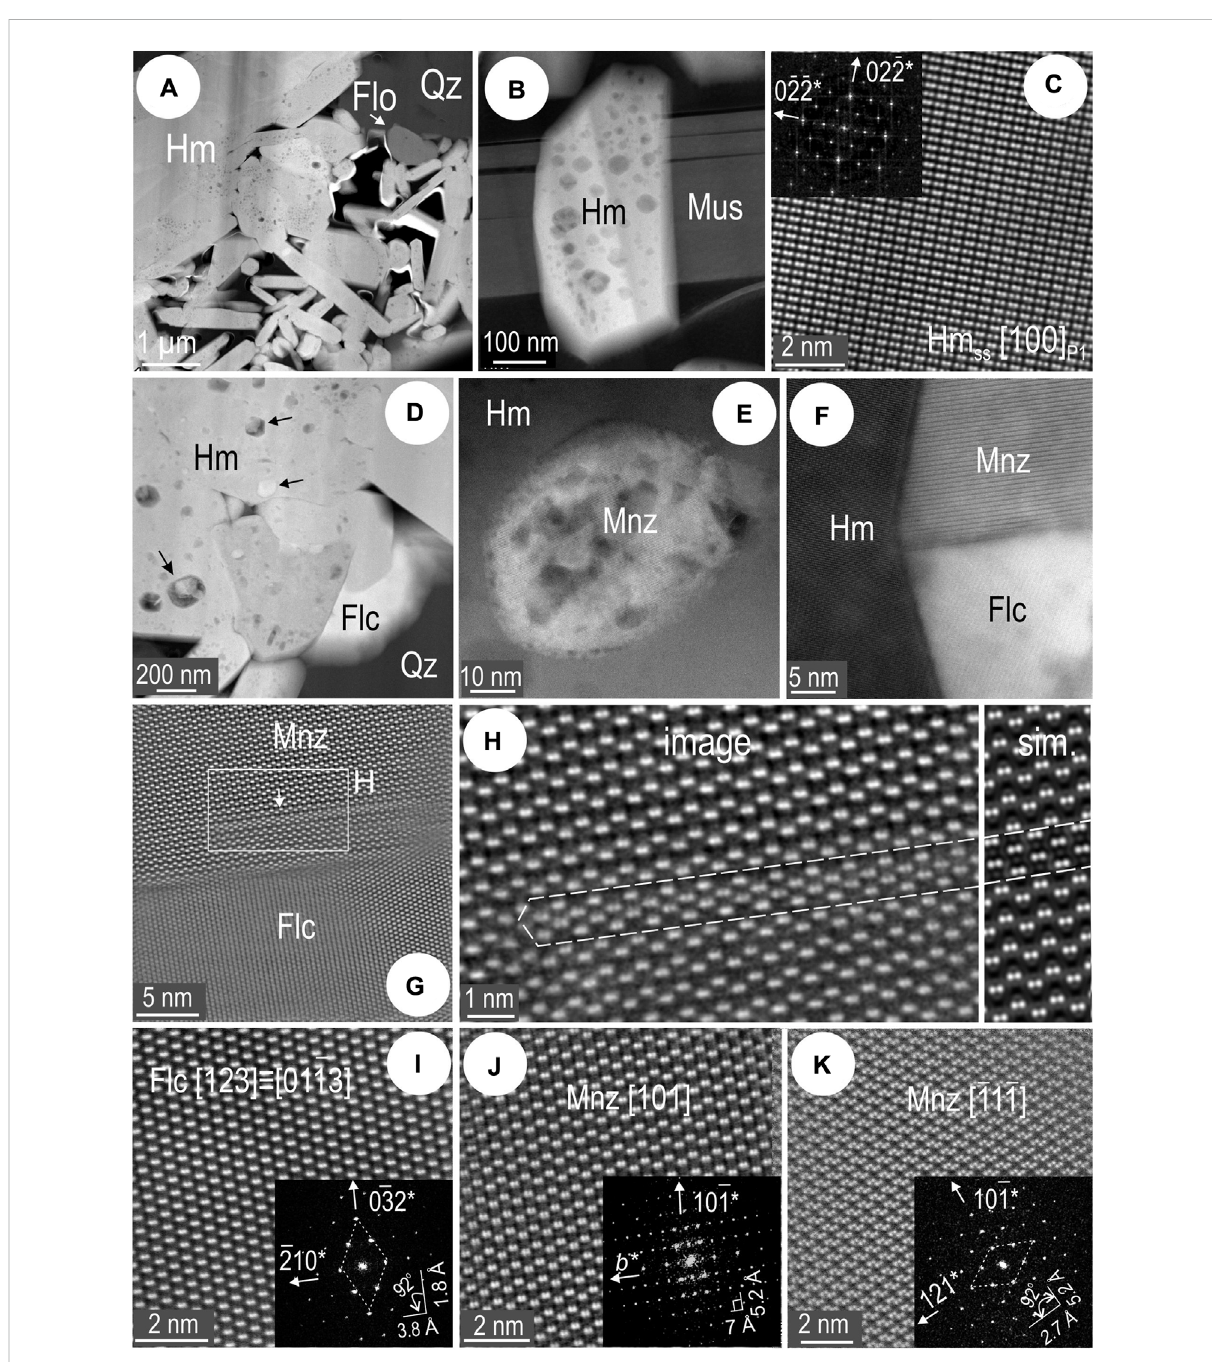
FIGURE 11 HAADF STEM images showing aspects of hematite and REE-minerals in sample 1T (foil Hm#1). Zone axes marked in square brackets and FFT patterns as insets. (A) Fine particle of fl orencite (Flo) harbored at the boundary between hematite (Hm) and quartz (Qz). Note the fi ne-grained, lamellar aggregate of hematite adjacent to coarser grains. (B) One of smallest hematite grains crosscuts muscovite (Mus). Note hematite is densely mottled with inclusions. (C) Atom-scale image and FFT pattern (inset) of hematite superstructure (Hm ss ) identi fi ed from inclusion-bearing hematite. (D) Fluocerite (Flc) fi ne particle at boundary between coarser hematite and quartz. Inclusions of various types in hematite are arrowed. (E) Singlemonazite(Mnz)NPwithinhematite. (F) CompositeNPcontainingmonaziteand fl uocerite. (G) Coherentboundarydomainbetweenmonazite and fl uocerite. (H) Detail of monazite [rectangle in (G) ] showing lattice-scale disorder as intergrowths of fl uocerite layers. Note similarity between atom-scale image and STEM simulation (sim.). (I) Atom-scale image of fl uocerite and (J,K) monazite on two different zone axes as